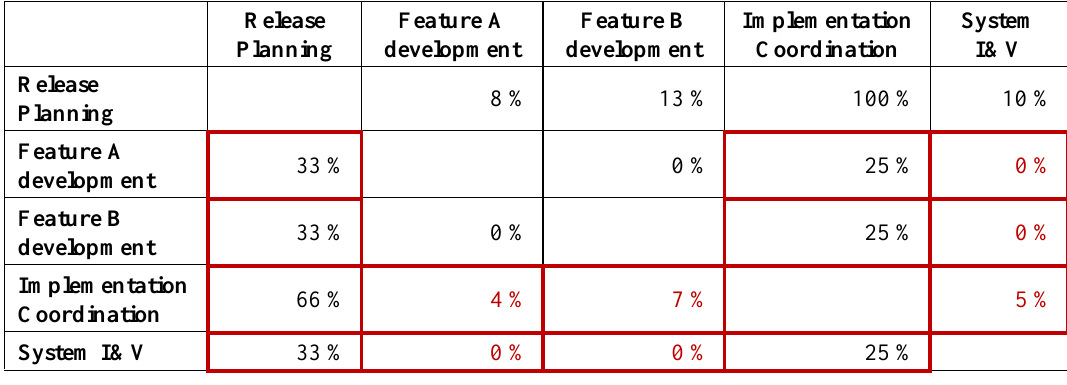
Table 4. A relative team intersection matrix derived from Table 3 and Table